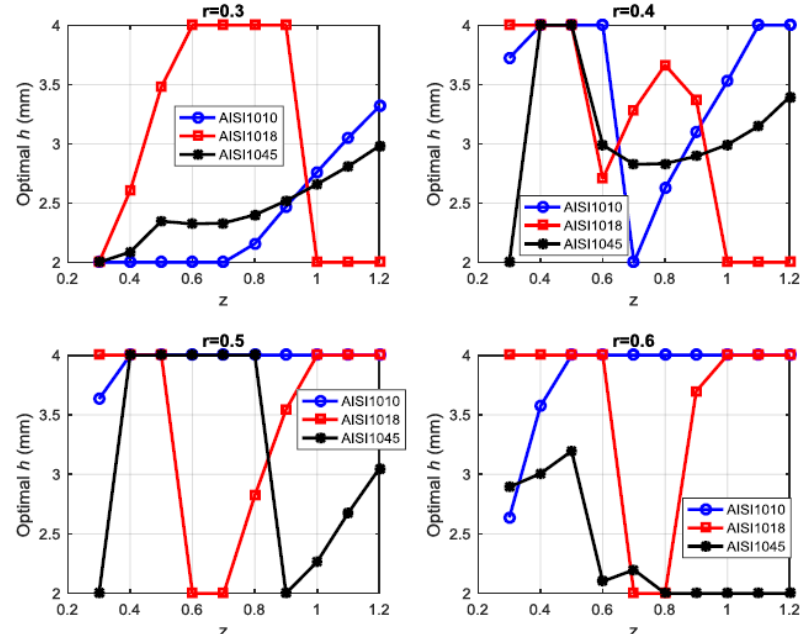
Figure 13. Comparison of optimal values of land height ( h ) of different steels.